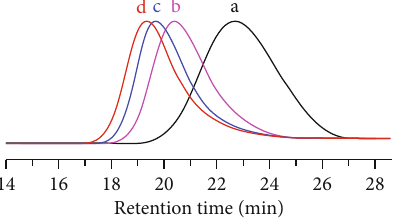
Figure 2: SEC traces of SMA synthesized via RAFT copolymerization of St and MAh initiated by Asc. Polymerization conditions: ½ St (cid:2) / ½ MAh (cid:2) / ½ DDMAT (cid:2) / ½ Asc (cid:2) = 148/148/1/1 ð½ DDMAT